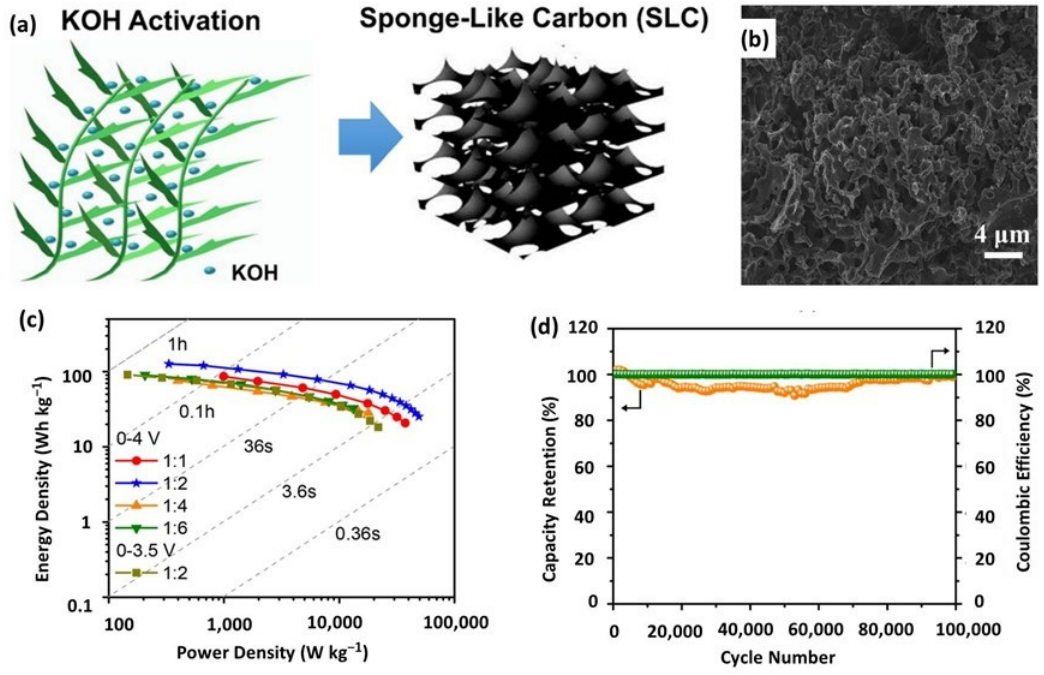
Figure 3. ( a ) Schematic illustration of the preparation process of SLC; ( b ) SEM image of SLC; ( c ) Ragone plots and ( d ) cycling stability of DC-LICs based on SLC electrodes. Reproduced with permission from Ref. [91]. Copyright 2019, American Chemical Society.